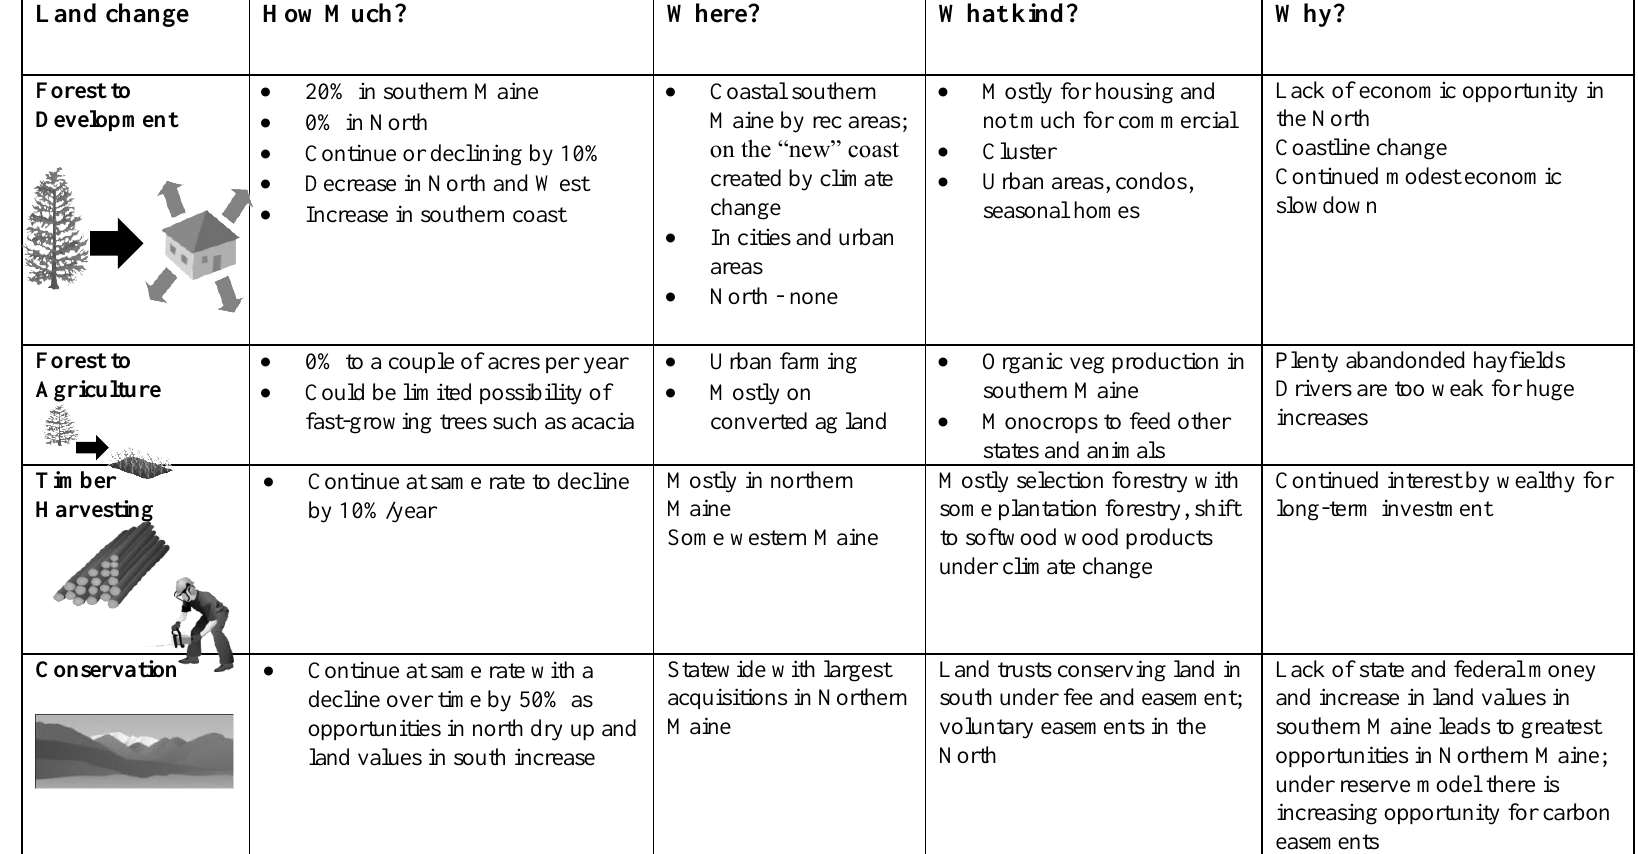
Table A2.11. The Way Life Might Be Land